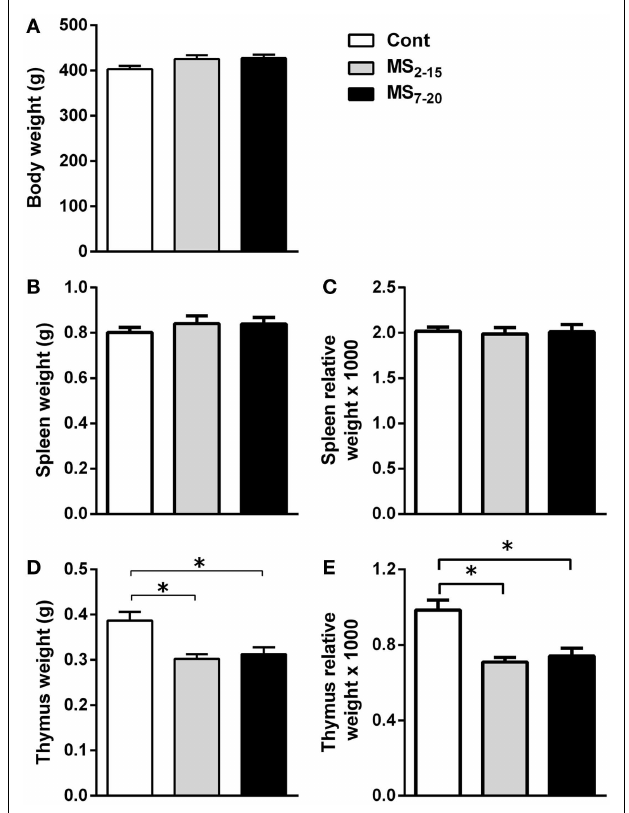
FIGURE 4 | Maternal separation caused a decrease in the thymus weight . (A) Body weight, (B) spleen weight, (C) spleen relative weight, (D) thymus weight, and (E) thymus relative weight were measured in Cont, MS 2–15 , and MS 7–20 groups at 3months of age. Each bar represents the mean + SEM from 18 to 27 rats per group from two